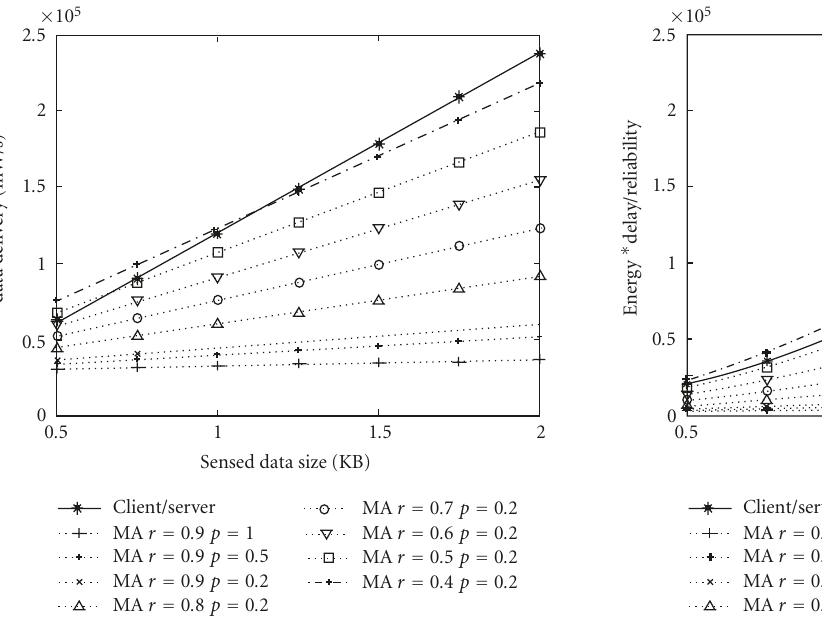
Figure 15: The impact of S data , r , and ρ on η